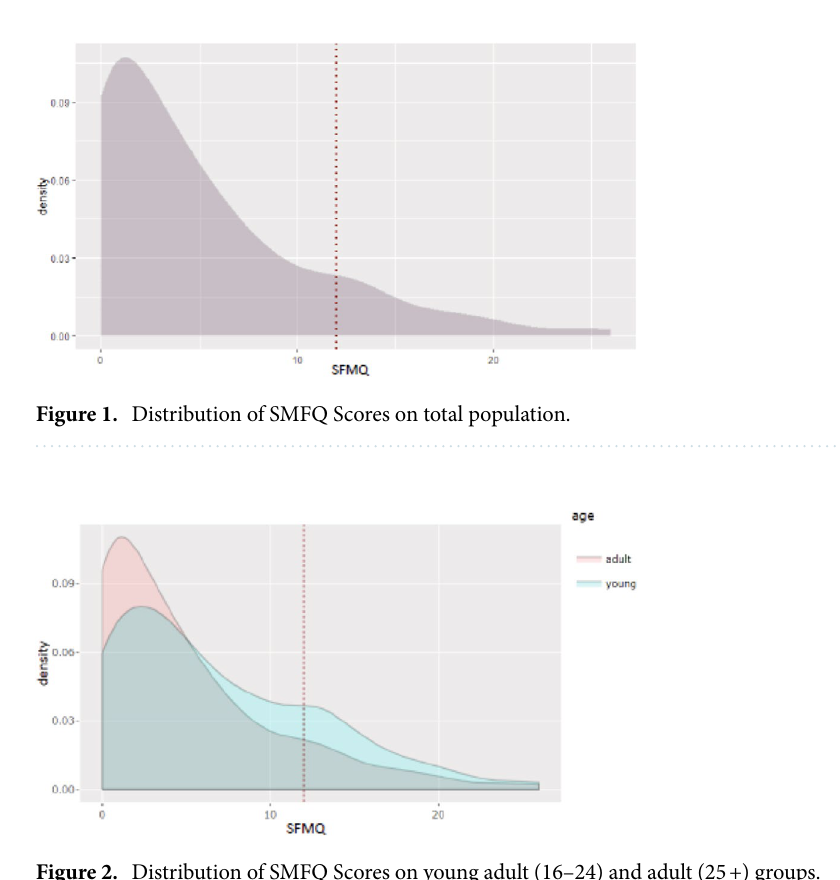
Figure 2. Distribution of SMFQ Scores on young adult (16–24) and adult (25 +)